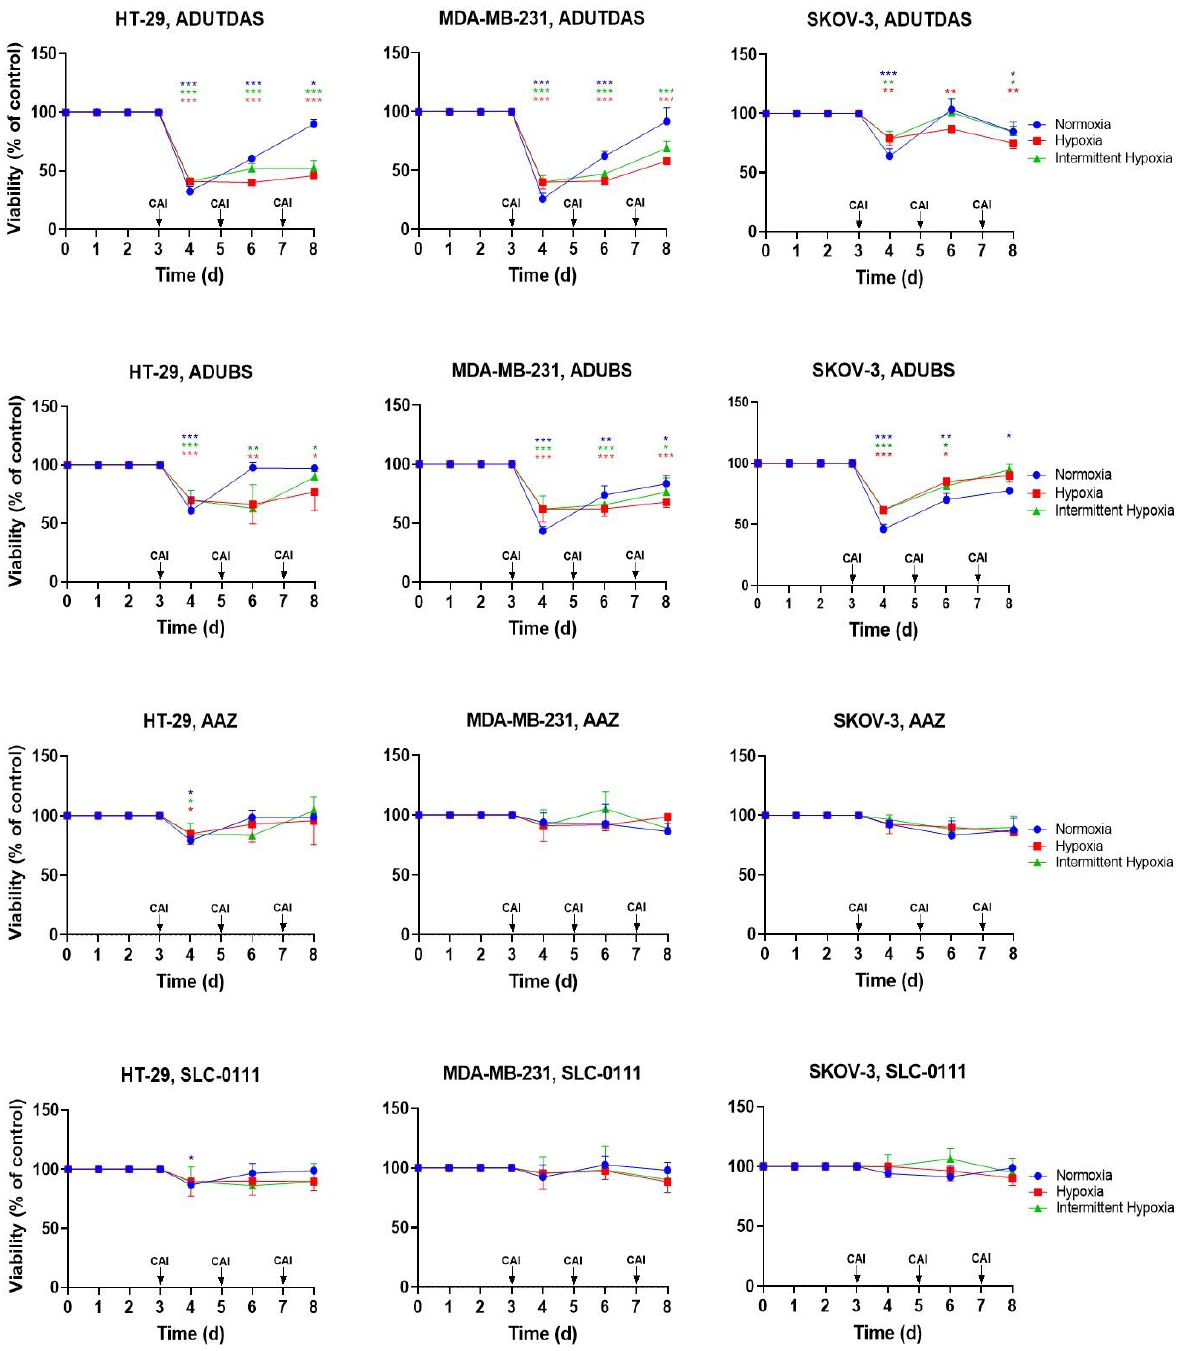
Figure 6. Viability of HT-29, MDA-MB-231 and SKOV-3 cells upon treatment with media containing 100 µM of ADUTDAS, ADUBS, AAZ or SLC-0111, at day 3, day 5 and day 7 of cell growth under normoxia, hypoxia and intermittent hypoxia. p -values were determined by one-way ANOVA. * p < 0.05, ** p < 0.01 and *** p < 0.001. Blue, red and green stars indicate statistically significant difference as compared to control within normoxic, hypoxic and intermittent hypoxic groups, respectively.